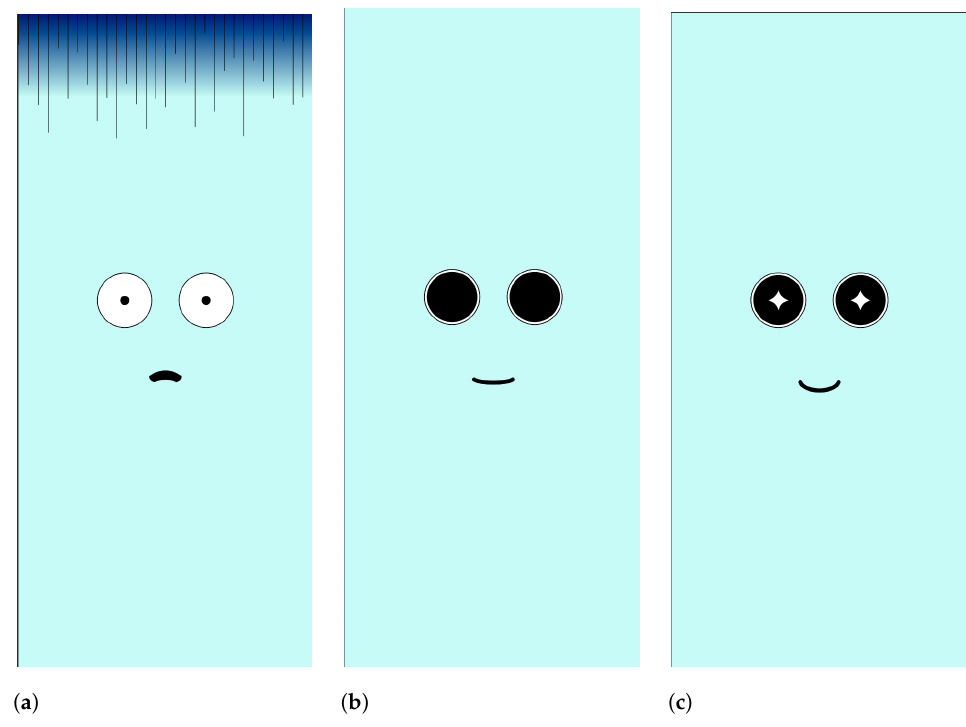
Figure 9. Face representing the different fuzzy values of the general state. ( a ) Face representing fear. ( b ) Face representing happy and standard. ( c ) Face representing happy and